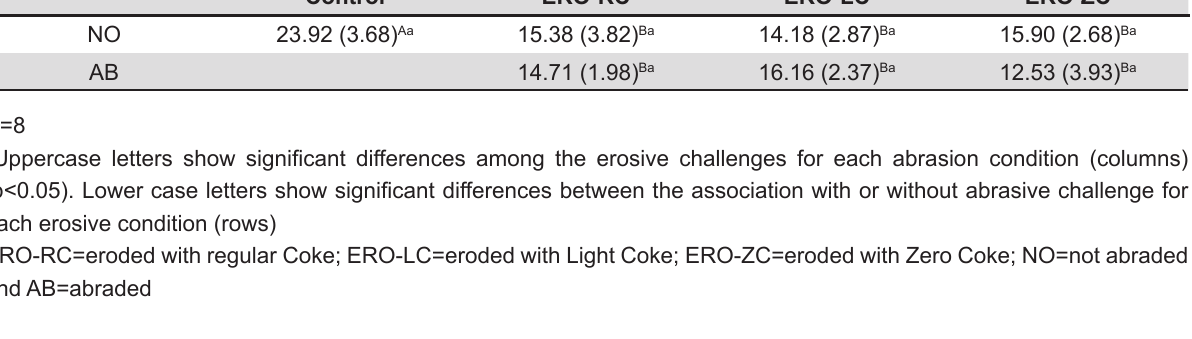
Table 2- Failure mode distribution according to challenge (%)